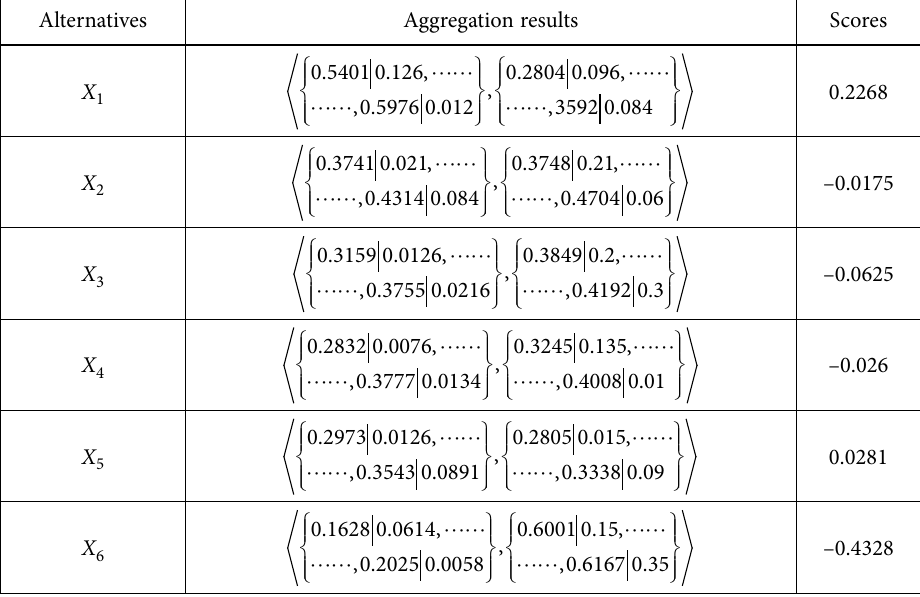
Table 15. The outcome with the PDHFWEA operator